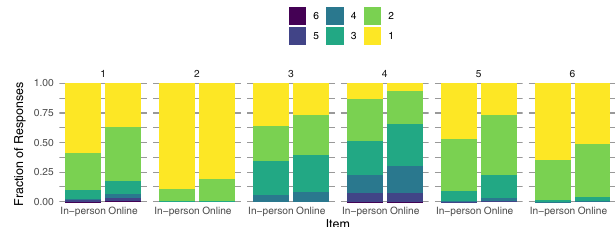
FIG. 3. Fraction of student responses that include 1 – 6 answer choices for each item. Items 1 and 6 have six answer choices; 2, 3, and 5 have five answer choices; and 4 has seven answer choices. (No student chose all seven of item 4 ’ s answer choices.).